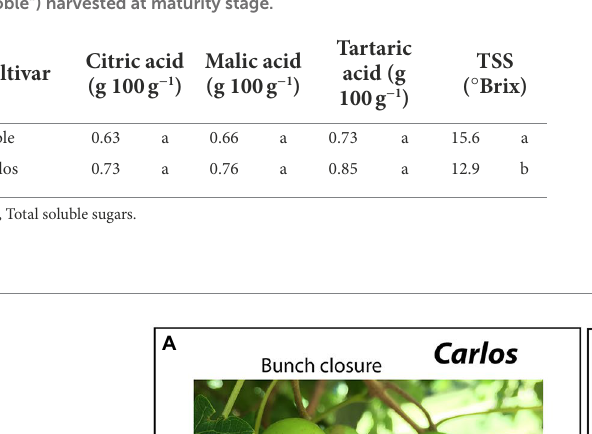
TABLE 1 TA and TSS of muscadine grape (cultivars “Carlos” and “Noble”) harvested at maturity stage.